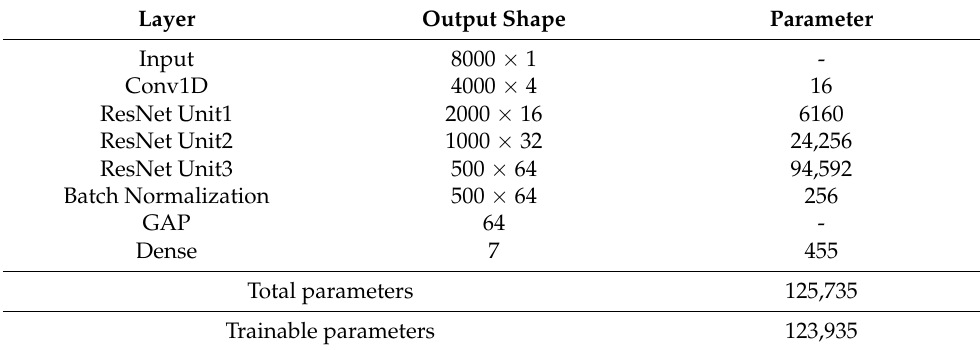
Figure 5. ResNet24-1D deep neural network structure for pulse modulation pattern recognition. The three ResNet Units have the same architecture. Here we only use the convolution of one modulation characteristic graph to simplify the network and save training time. Before the full connection layer, a global average pooling was used to extract the important features of each channel. Table 1. Parameters of